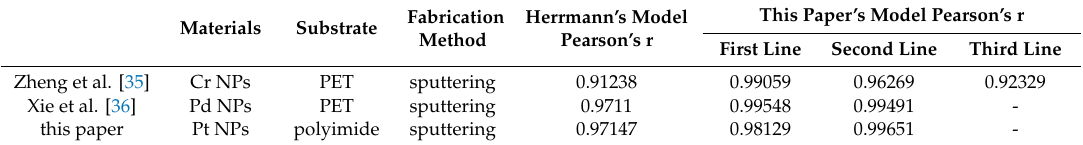
Table 1. Comparison between this paper and two strain-sensing devices based on solvent-free NPs Materials